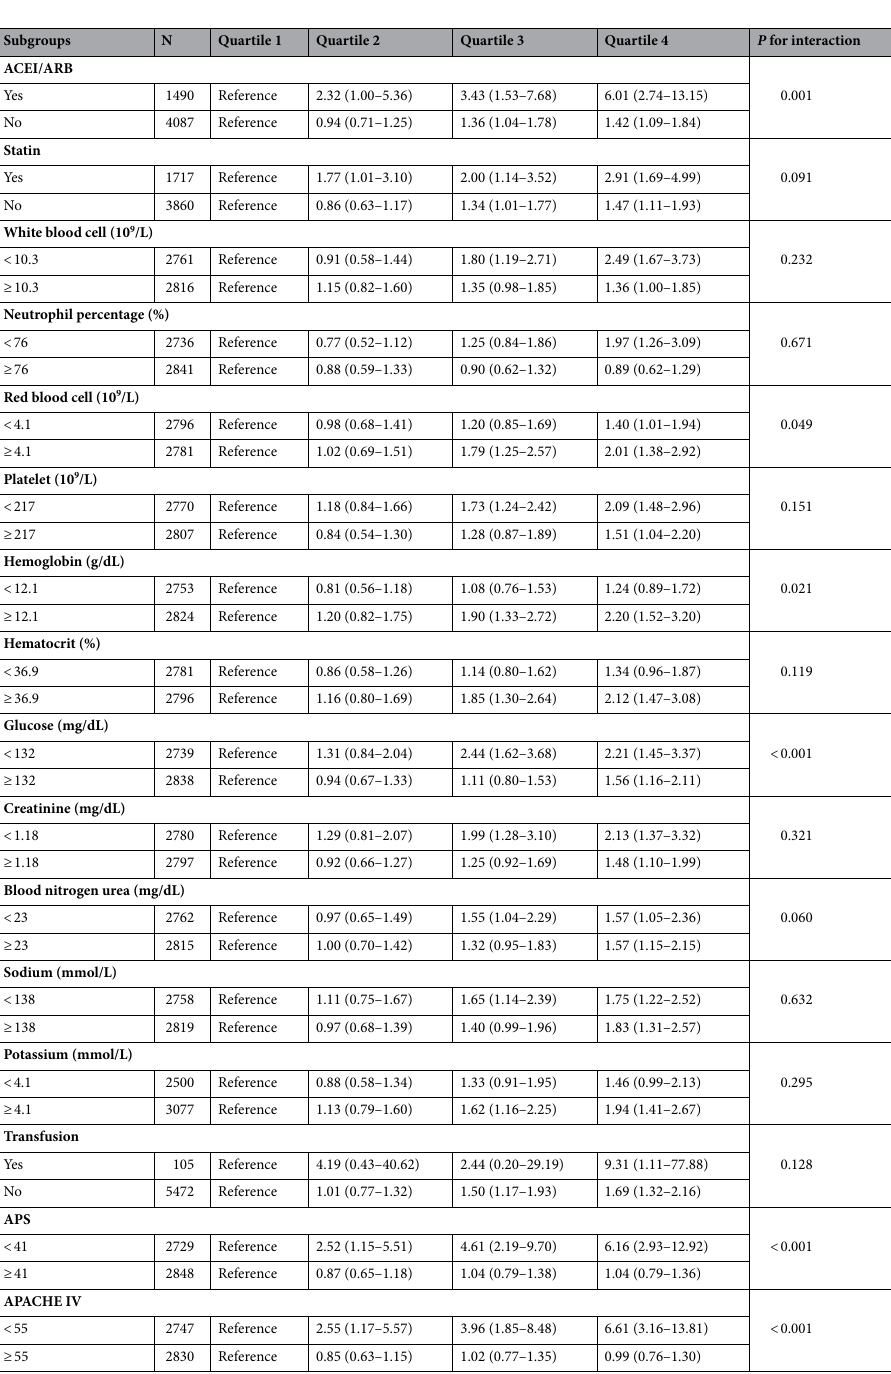
Table 4. Subgroup analysis of associations between in-hospital mortality and PLR. Binary logistic regression analysis was used and results were presented as OR (odds ratio) and 95% CI (confidence interval). P for interaction was calculated using binary logistic analysis to determine whether there is interaction between different subgroups and PLR quartiles. STEMI ST-elevation myocardial infarction, NSTEMI non-ST-elevation myocardial infarction, COPD chronic obstructive pulmonary disease, PLR platelet-lymphocyte ratio, ACEI angiotensin-converting enzyme inhibitor, ARB angiotensin receptor blocker, APS acute physiology score, APACHE IV Acute Physiology and Chronic Health Evaluation